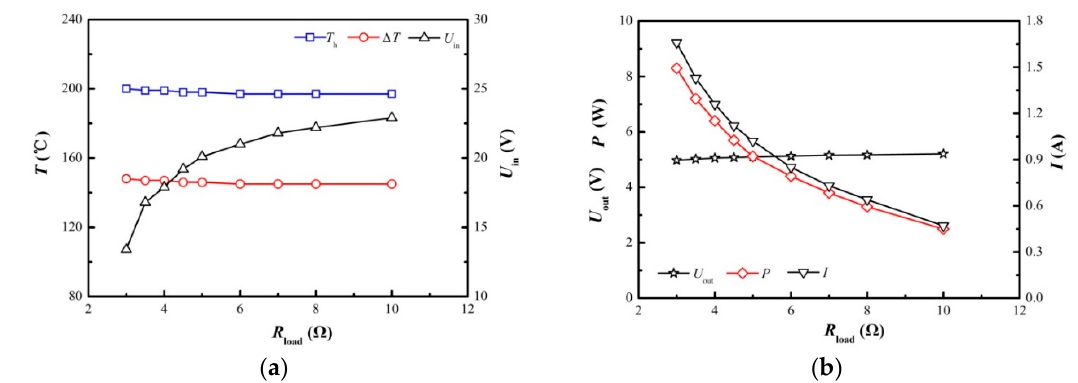
Figure 5. The power load feature of the STEG with a DC-DC converter. ( a ) The hot end temperature, T h , temperature difference, Δ T , and the closed circuit input voltage, U in ; ( b ) the output voltage, U out , the load current, I , and the electric power output, P . (Cod1 heat conducting plate, HS1 heat sink, YNJAD cooling fan and Cof1 TE module configuration).